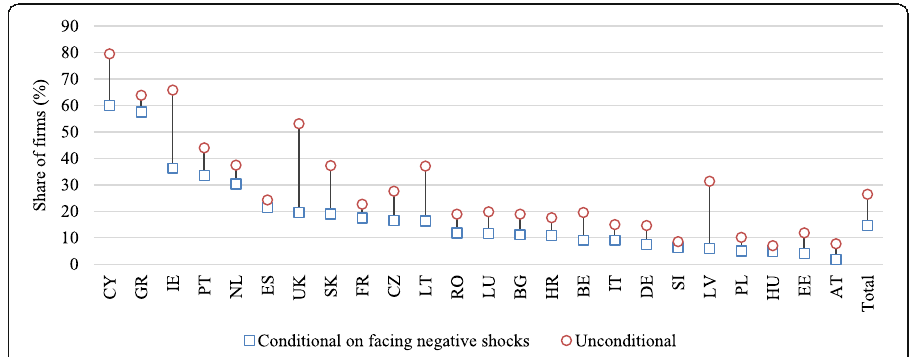
Fig. 2 Share of firms freezing wages in 2010 – 2013, %. WDN3, authors ’ calculation. The data are weighted to reflect overall employment in the country and rescaled to exclude